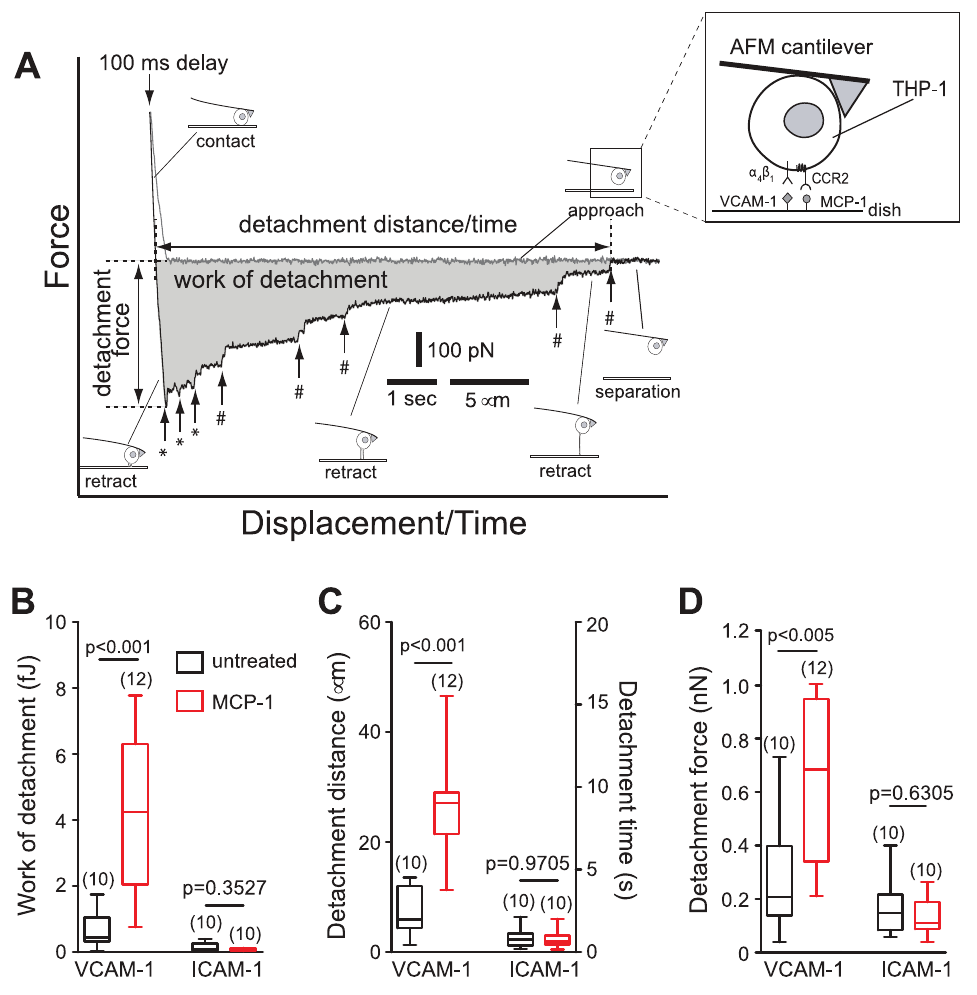
Figure 1. AFM measurement of THP-1 adhesion to immobilized adhesion molecules. (A) AFM force-displacement curve of THP-1 adhesion to VCAM-1 co-immobilized with MCP-1. The approach (gray) and retract (black) traces of the AFM measurement are shown. Shaded area represents the work of detachment done by the cantilever to completely detach the cell from the substrate. Vertical arrows denote rupture events mediated by cytoskeleton-anchored (*) or membrane-tethered integrins ( # ). The inset is a representation of the experimental system. A flexible AFM cantilever was used to immobilize a THP-1 cell expressing a 4 b 1 and LFA-1 integrins and CCR-2 receptors of MCP-1, which was coimmobilized with ICAM-1 or VCAM-1 on the dish surface. Box-and-whisker plots of the (B) work of detachment, (C) detachment distance and detachment time, and (D) detachment force of THP-1 cell adhesion to VCAM-1 and ICAM-1, with and without co-immobilized MCP-1. The number in parenthesis above the plots corresponds to the number of cells studied. Numbers above each horizontal line represent the p-value from Mann-Whitney tests between respective measurement conditions. AFM measurements were acquired with a scan speed of , 3 m m/s and a dwell time of 100 ms between approach and retract